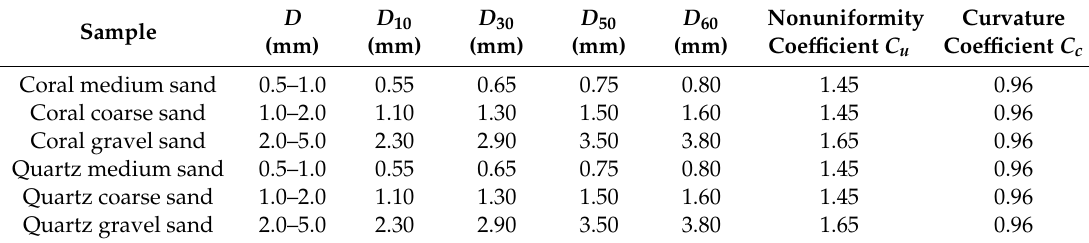
Table 1. Particle gradation parameters of the tested